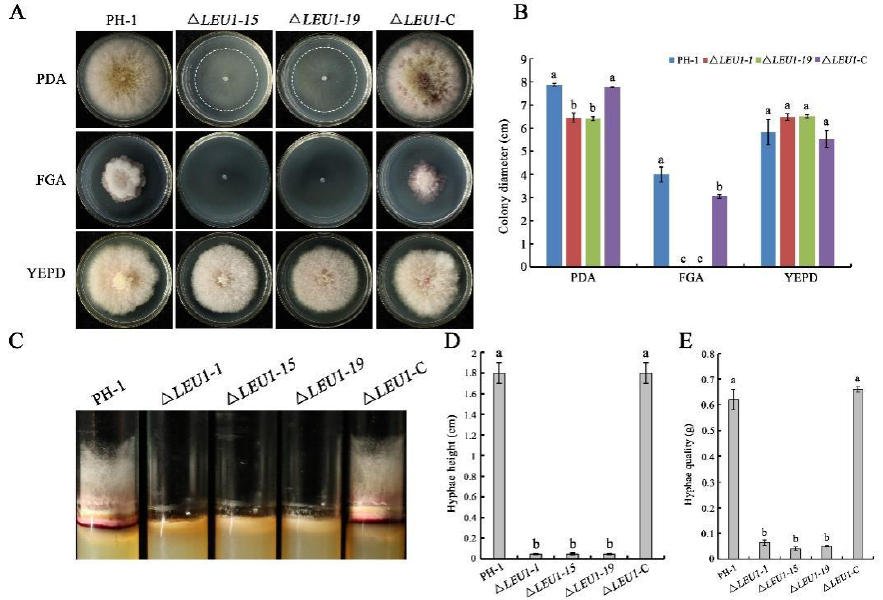
Figure 2. Hyphal growth of PH-1, ∆ LEU1 , and ∆ LEU1 -C strains. ( A ) Colonies of the wild type (PH-1), FgLEU1 deletion mutants, and complemented strains were cultured on PDA, FGA, and YEPD agar plates after 4 days at 25 ◦ C. ( B ) Height of aerial mycelium in test tubes containing PDA medium after 4 days at 25 ◦ C. ( C ) Colony diameters of strains cultured on PDA, FGA, and YEPD plates. ( D ) Colony height of strains cultured in tubes with PDA. ( E ) Hyphal quality of strains cultured in potato dextrose broth (PDB) at 25 ◦ C for 5 days at 180 rpm. Different letters on the bars for each treatment indicate significant differences at p < 0.05 by Duncan’s multiple range test. Measurements represent the average of three independent experiments. All experiments were repeated three times with three replicates at each time.